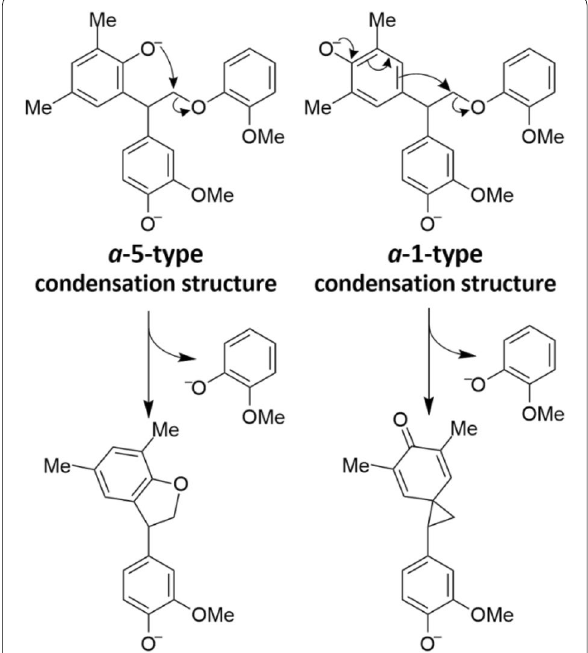
Fig. 1 Condensation reactions of lignin proposed by Gierer et al. [1–9] The chemical species enclosed by the solid and dotted circles are nucleophiles and electrophiles, respectively. The square shows the carbon numbering of a lignin unit in lignin chemistry